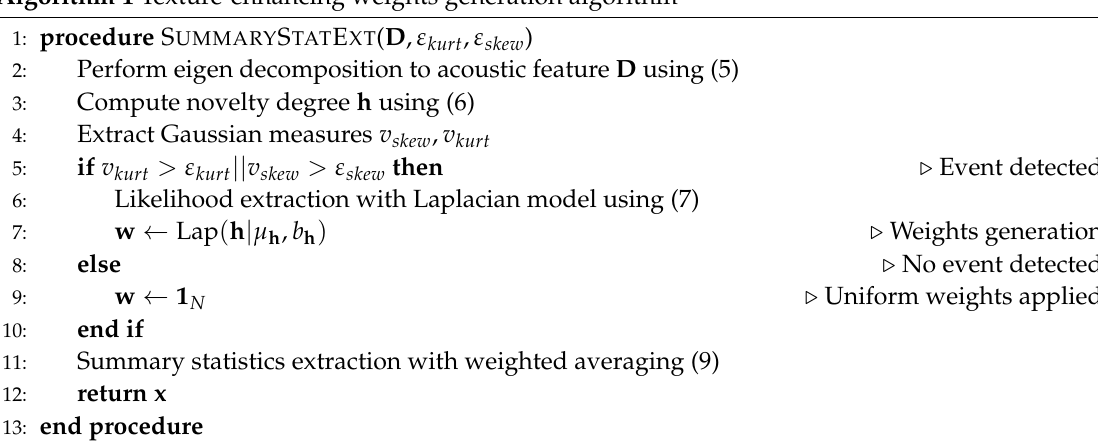
Algorithm 1 Texture-enhancing weights generation